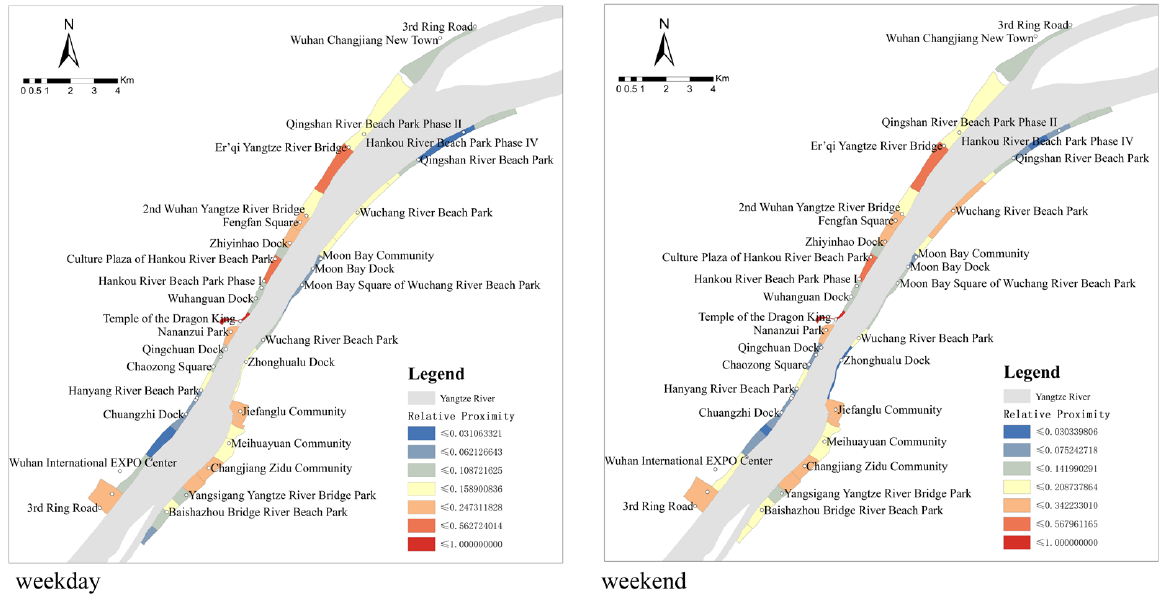
Figure 10. The spatiotemporal attractiveness distribution of the riverside area of Wuhan.